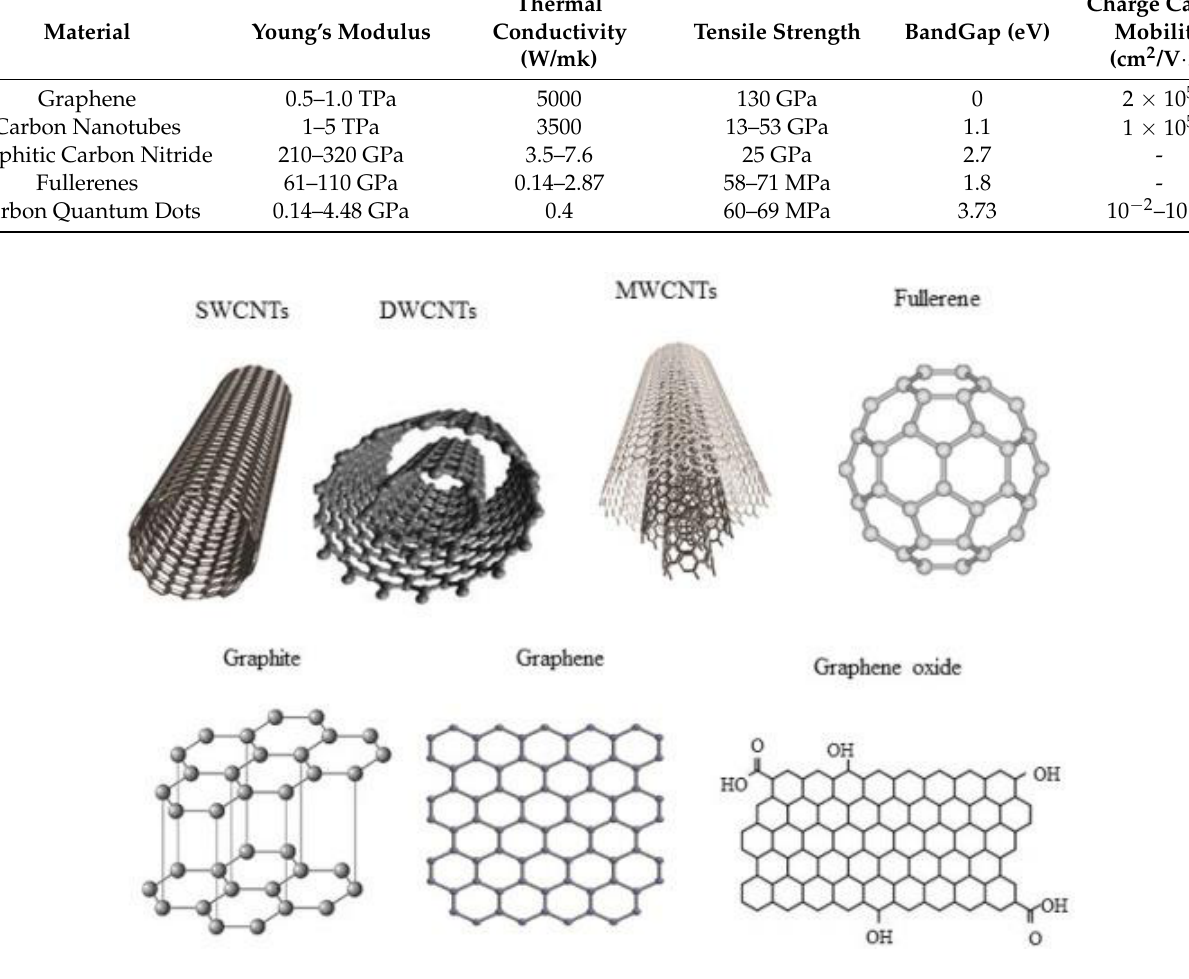
Figure 1. Structures of different Carbon-based nanomaterials. Reprinted/adapted with permission from Ref. [31]. Copyright © 2020, Elsevier.